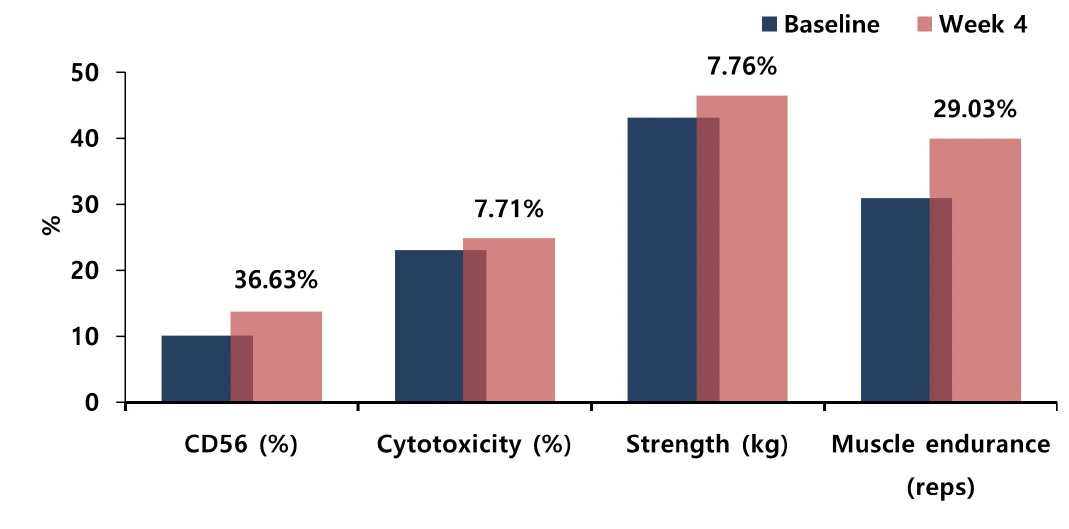
Fig. 4. Changes of NK cell (CD56), cytotoxicity and physical fitness after 4